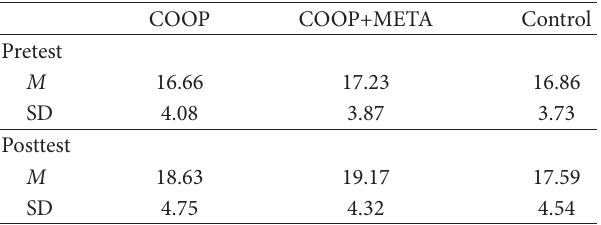
T 6: Mean scores and standards deviations on metacognition (regulation facet) by time and